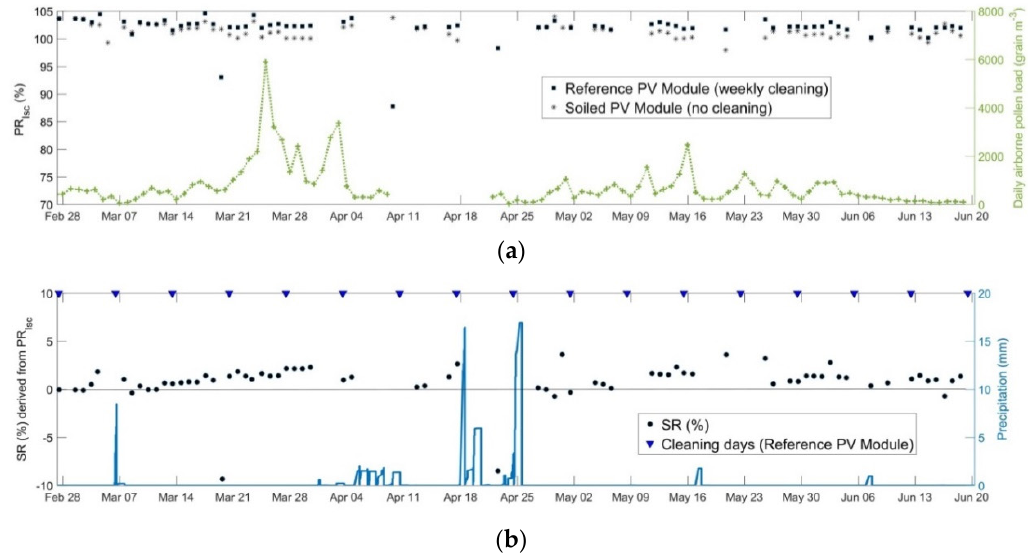
Figure 8. Performance of two identical mc-Si modules at tilt angle = 8 ◦ ; one module was cleaned weekly (“reference PV module”) and the other was kept uncleaned (“soiled PV module”). ( a ) performance ratios calculated from short-circuit measurements and daily airborne pollen load and ( b ) soiling ratios derived from the performance ratios and daily precipitation regime.